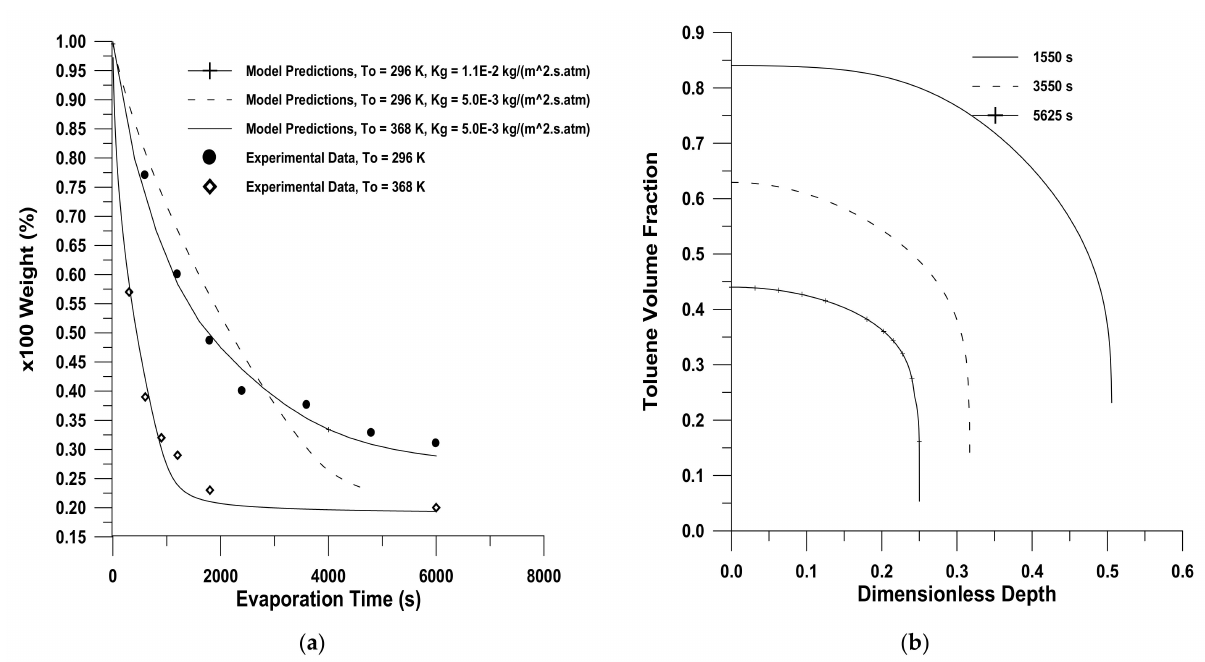
Figure 2. Fickian diffusion for the system poly(methyl methacrylate)/toluene (used with copyright permission) [32]. ( a ) Polymeric coating mass versus drying time for various drying temperatures. Initial coating thickness = 2 mm; (x ∞ = 0). ( b ) Toluene volume fraction profiles for different drying times. Drying air = 296 K; Initial coating thickness = 2 mm; (x ∞ =